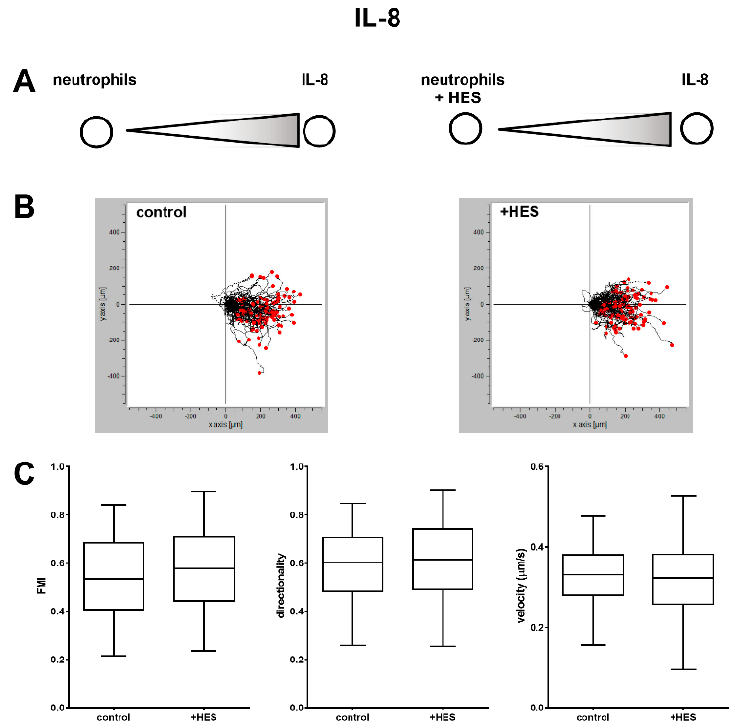
Figure 3. Migration of neutrophils not treated (control) or treated (+ HES) with hydroxyethyl starch in response to IL-8. Low magnification time-lapse images were obtained and processed using cell-tracking algorithms. ( A ) Experimental setup. ( B ) Detailed migration trajectories of representative cells ( n = 100) from control and HES-treated cells; individual tracks were transposed so that each had its start at the origin. ( C ) Comparison of forward migration index (FMI), parallel to the gradient and calculated as the ratio between the x coordinate of the cell’s end point of migration and the total distance accumulated), directionality (representing a measurement of the directness of cell trajectories, the ratio of the Euclidian distance and the total accumulated distance of a cell), and velocity (displacement/time). None of the values were different between the control and the cells treated with HES, suggesting that hydroxyethyl starch did not impair the migration of cells in response to IL-8. The results are the mean ± SD of three independent experiments.